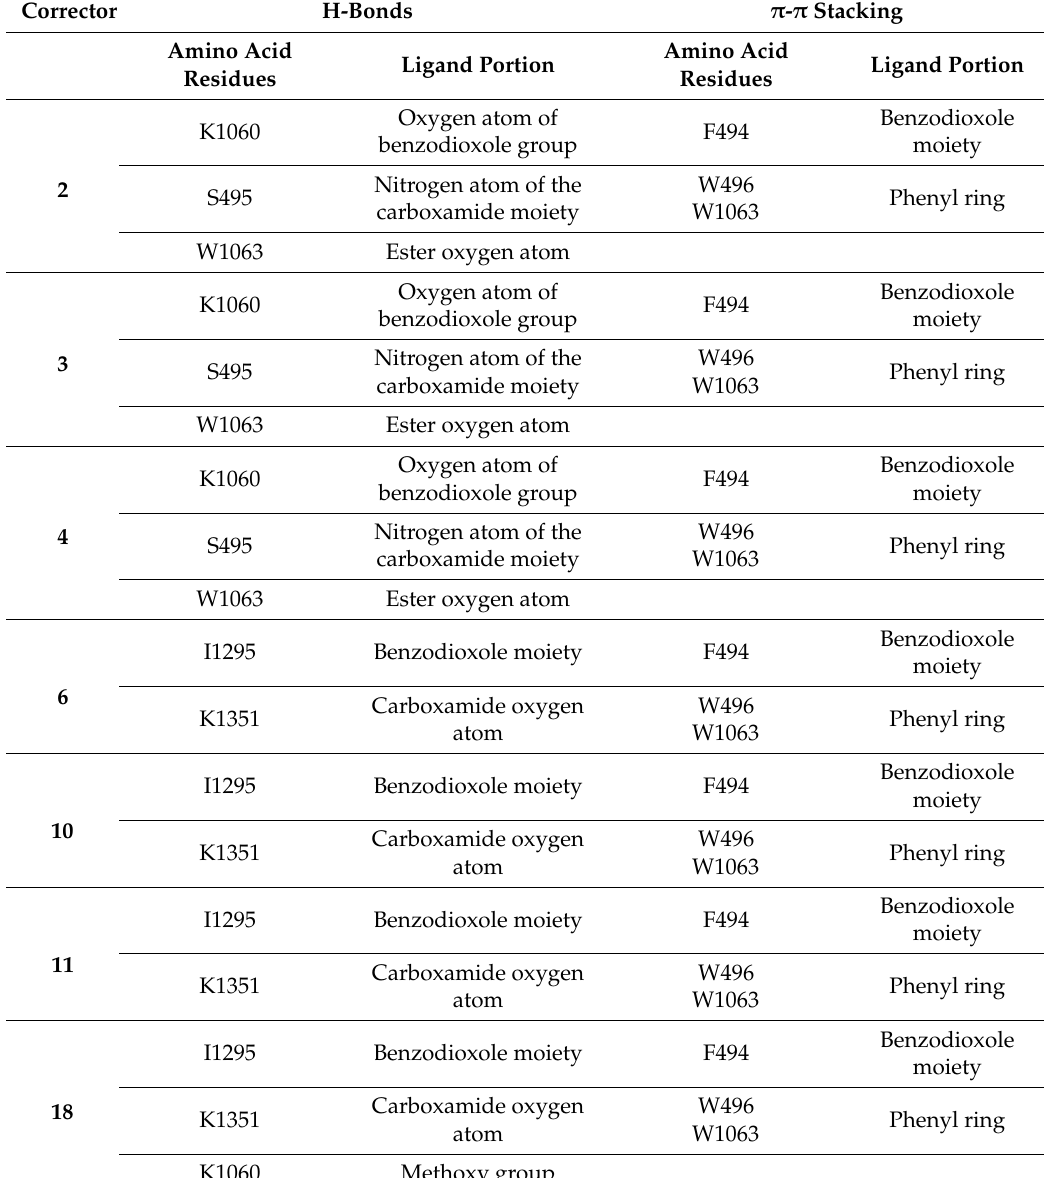
Table 2. Pattern of the most important interactions within the modelled F508del-CFTR protein observed for the most promising hybrids, chosen as representative of this series of